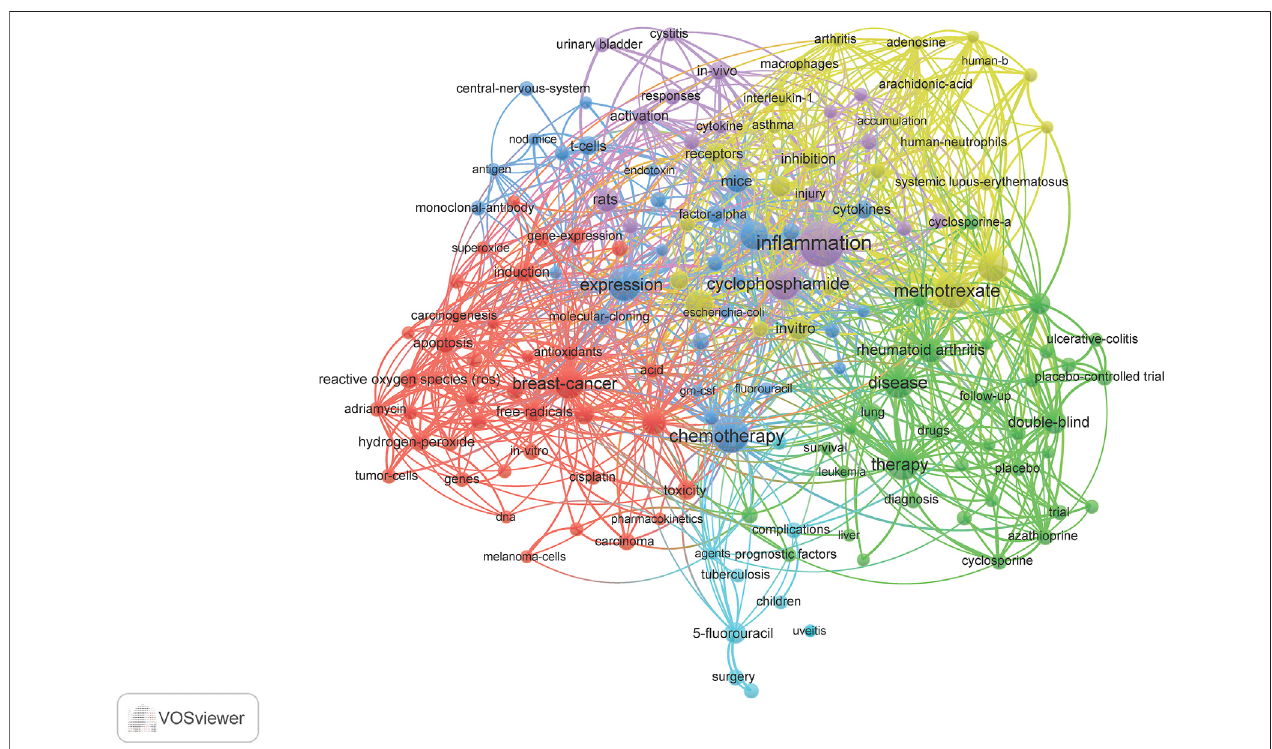
FIGURE 3 | Term map showing the visualization of 154 terms that occurred at least 5 times in documents between 1990 and 1999. Refer to Supplementary Table S2 for a complete list of